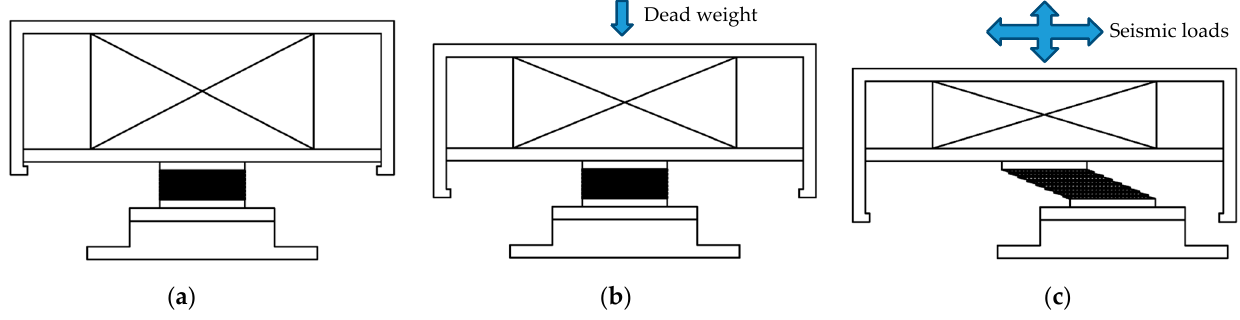
Figure 2. Schematics of 3D seismic isolator’s motions: ( a ) Without loads; ( b ) with vertical static load; ( c ) with horizontal and vertical seismic loads.